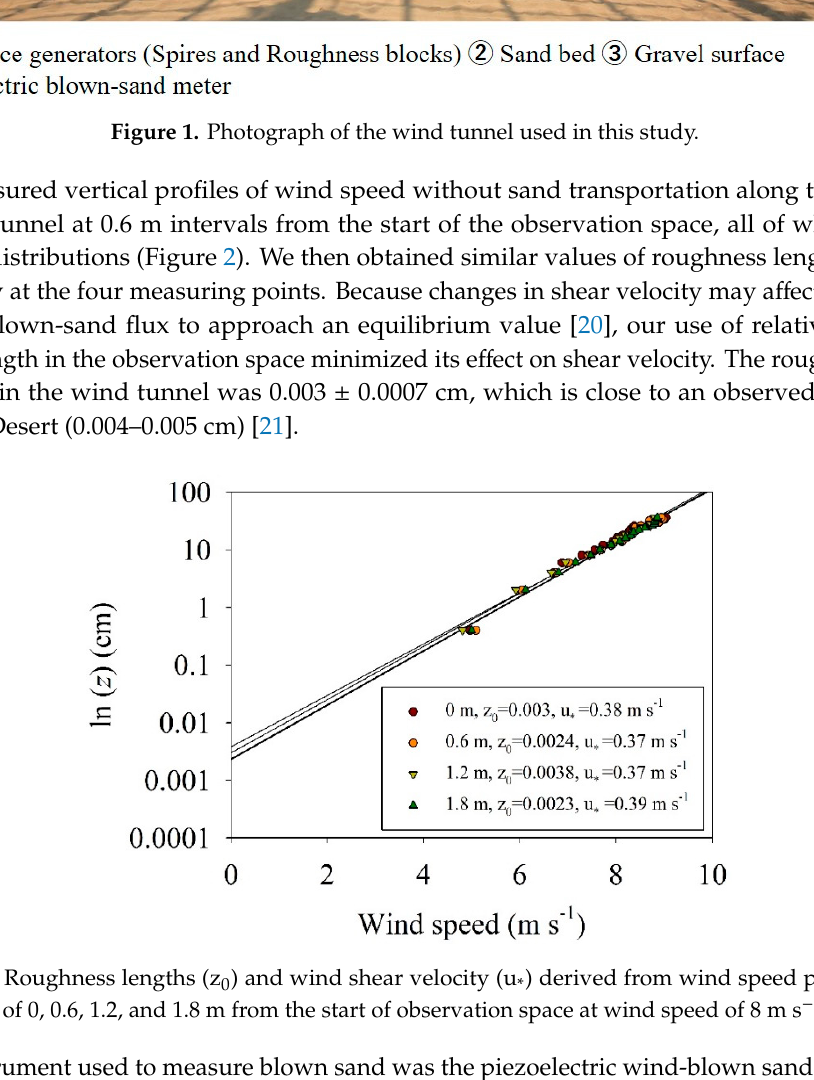
Figure 2. Roughness lengths ( z 0 ) and wind shear velocity ( u *) derived from wind speed profiles at distances of 0, 0.6, 1.2, and 1.8 m from the start of observation space at wind speed of 8 m s − 1 .